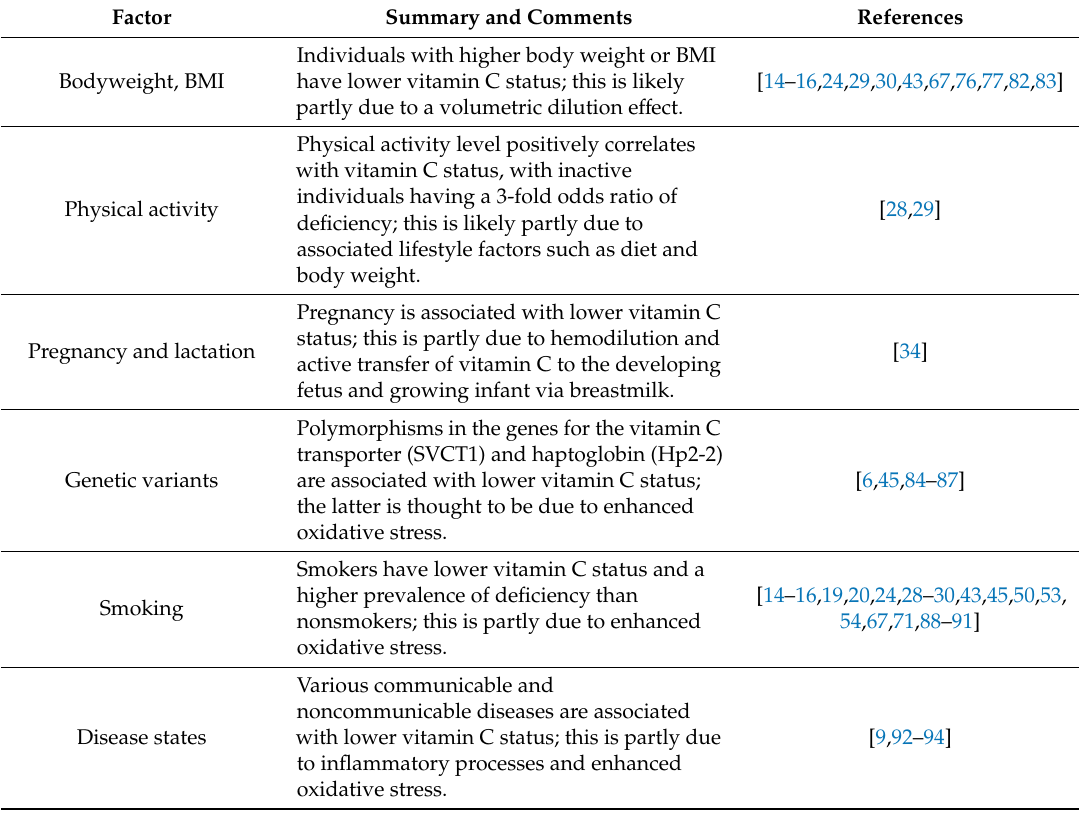
Table 5. Health aspects that a ff ect vitamin C